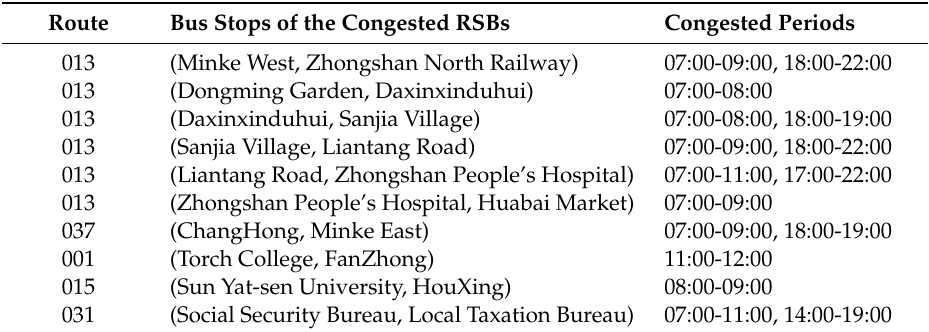
Table 7. Examples of the congested RSBs.